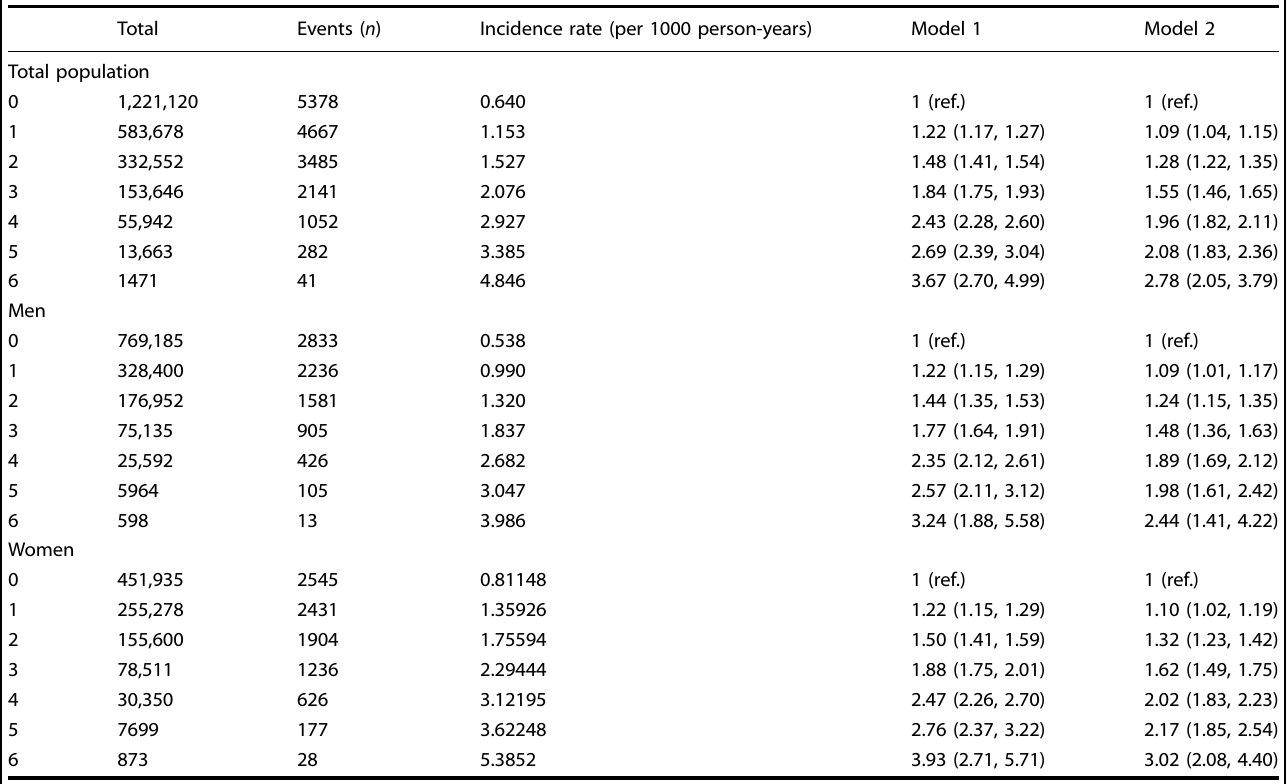
Table 3. The risk of Parkinson ’ s disease according to the diabetes severity score. Total Events ( n ) Incidence rate (per 1000 person-years) Model